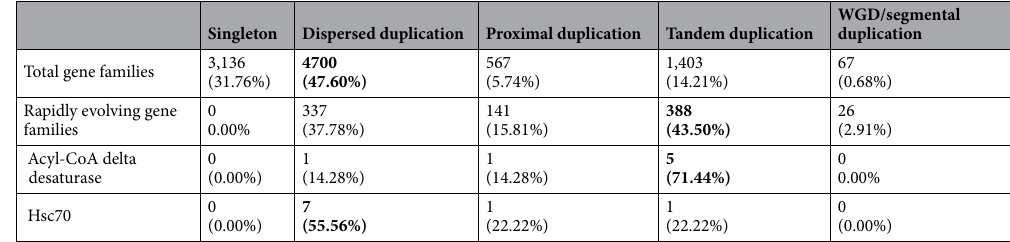
Table 4. Gene duplication in the P. steinenii genome. Proportions according to origins of the duplicate gene categories are shown in parentheses and the highest result in each row is indicated in bold.